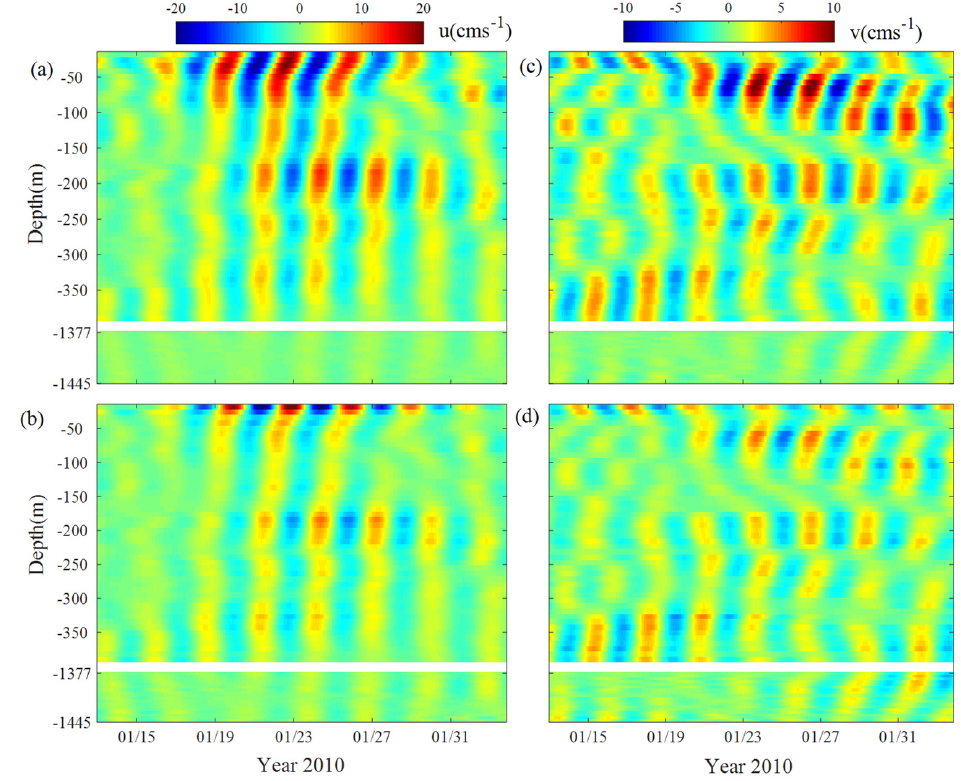
Figure 6. Depth-time maps of raw near-inertial velocities ( a , c ) and WKB-scaled velocities ( b , d ) in eastward ( a , b ) and northward ( c , d ) directions in January 2010.